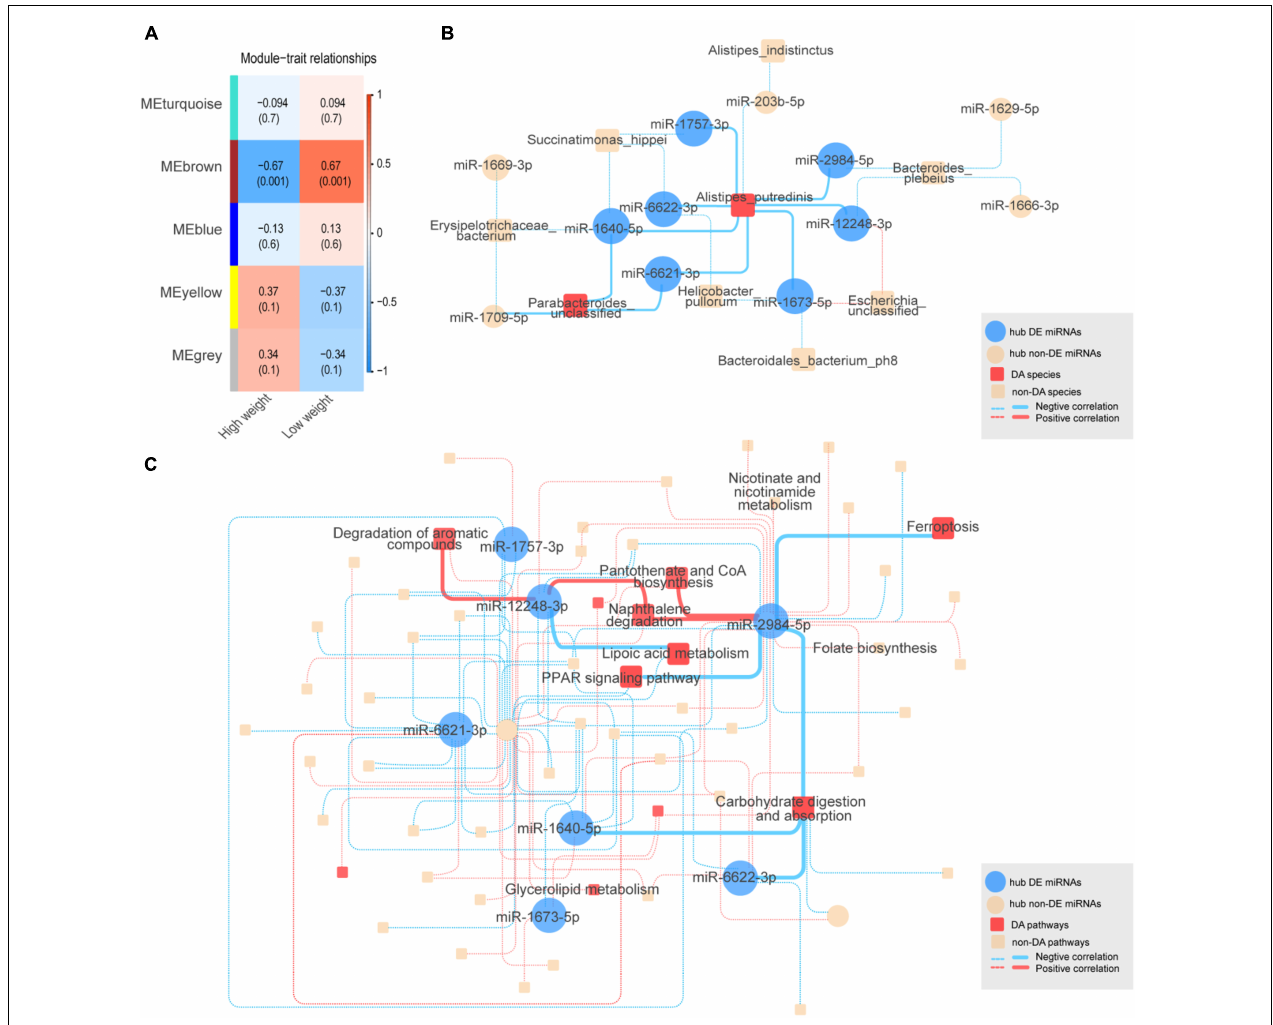
FIGURE 3 | (A) Chicken miRNA co-expression module and body weight correlations with corresponding p values (in parentheses). The left panel shows five modules with different colors. The color scale on the right shows module-trait correlation from –1 (blue) to 1 (red). (B) The complex interactive relationships between hub chicken miRNAs and intestinal microbiota. Blue solid circles represent significantly differentially expressed (DE) hub miRNAs between HWS and LWS. Yellow solid circles represent non-DE hub miRNAs. Red squares represent significantly differentially abundant (DA) microbial species. Red and blue lines represent the respective positive and negative correlations between miRNAs and microbial species. The interactions between DE hub miRNAs and DA species are represented by solid lines, with other interactions shown as dashed lines. (C) KEGG pathway. Blue solid circles represent significantly differentially expressed (DE) hub miRNAs between HWS and LWS. Yellow solid circles represent non-DE hub miRNAs. Red squares represent significantly differentially abundant (DA) pathways. Red and blue lines, respectively, represent the positive and negative correlations between miRNAs and microbial pathways. The interactions between DE hub miRNAs and DA pathways are shown as solid lines, with other interactions by dashed